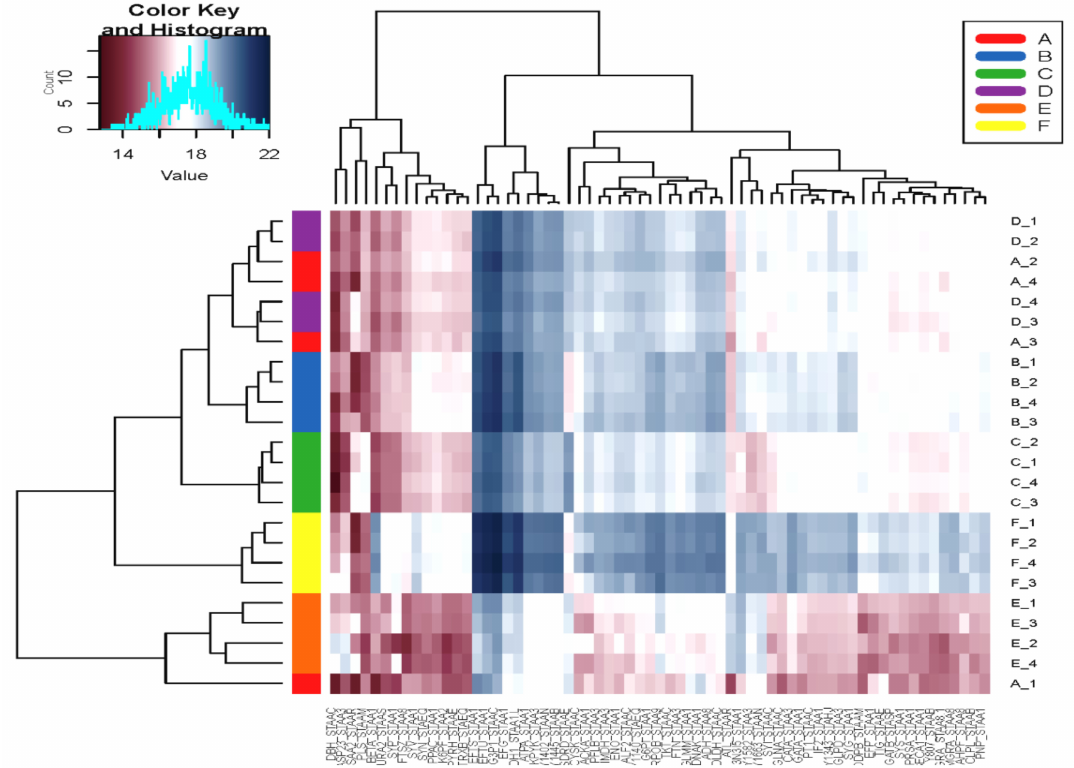
Figure 5. Heatmap represents the abundance of altered proteins extracted from the cells harvested at mid-exponential phase, grown under normal conditions (reference control, A ) compared to the five di ff erent sets of experimental conditions ( B − F ). The key color indicates the protein